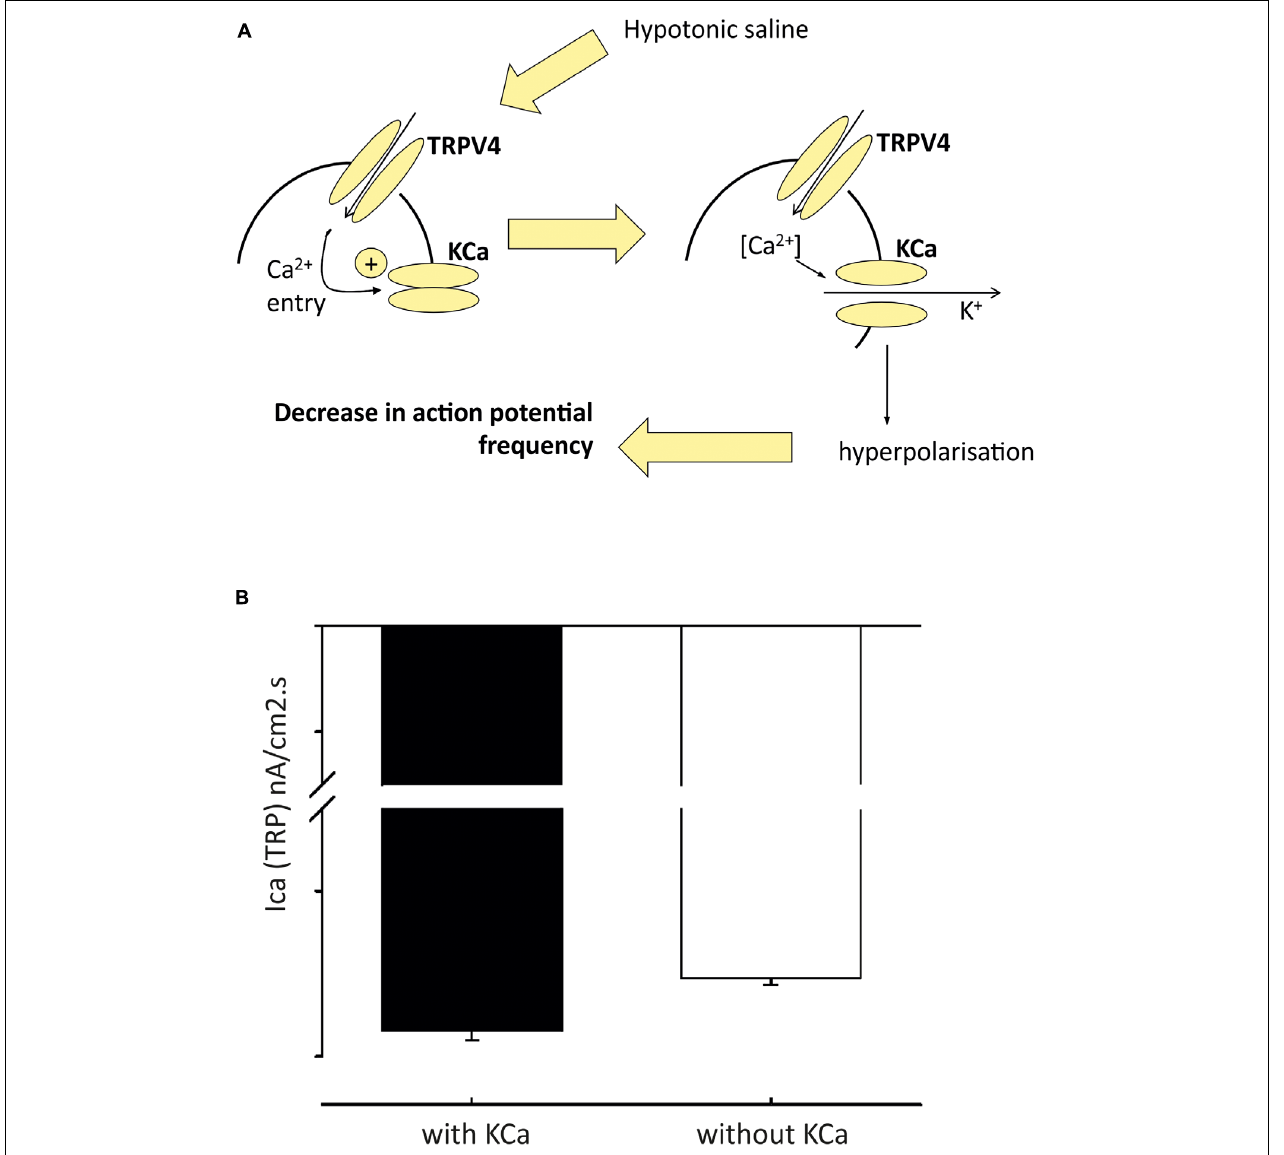
FIGURE 4 | Model of pre-autonomic neurone regulation by osmolality. From detailed analysis of the model (in Figure 3 ) we predicted that inward TRP dependent Ca currents would be increased in the presence of K Ca block (A) ; and we then validated this by experiment (B) Figure from Feetham et al. (2015b) with permission of the copyright holder John Wiley & Sons,